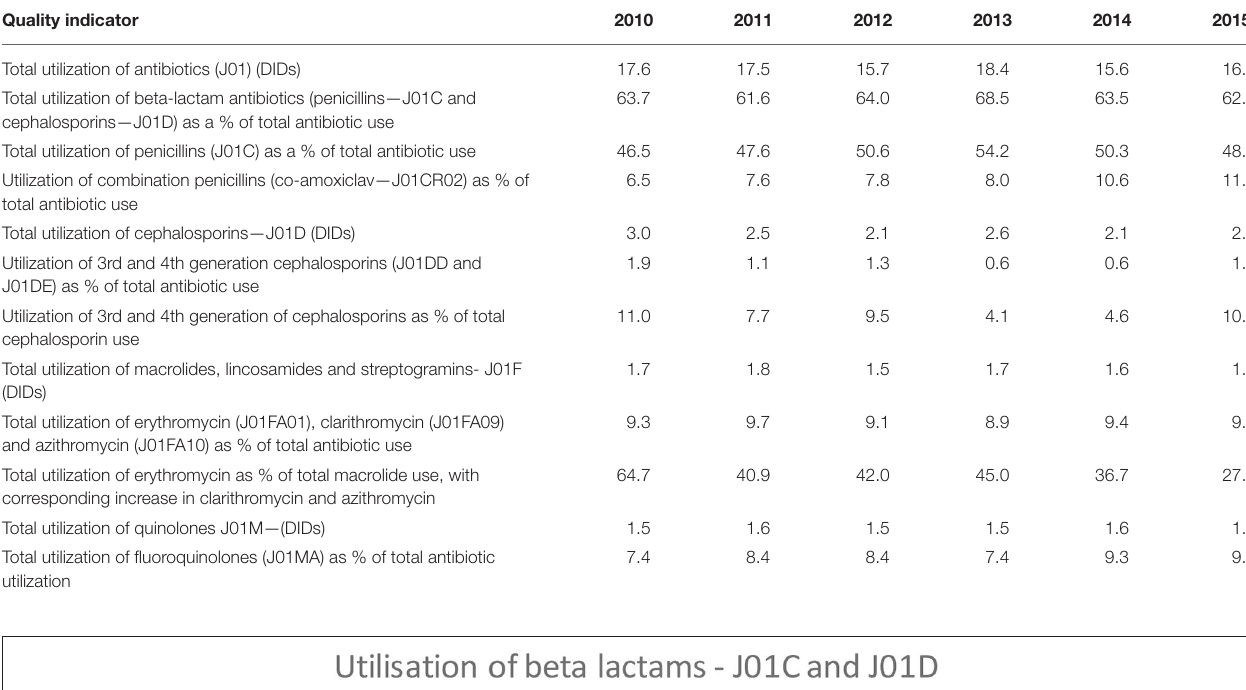
TABLE 4 | Quality indicators for antibiotic utilization in the Republic of Srpska from 2010 to 2015. Quality indicator